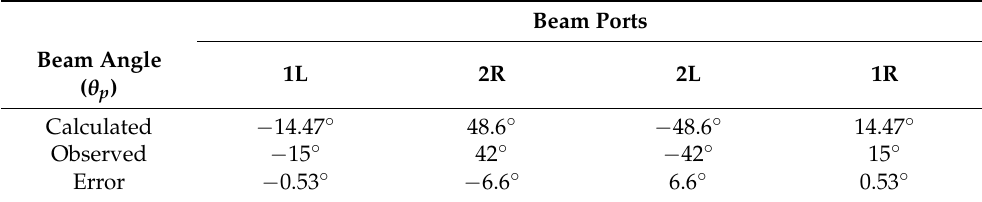
Table 9. Calculated and observed beam angles for the 4 × 4 Butler matrix after connecting to the 4 × 1 antenna array for individual beam port excitation.